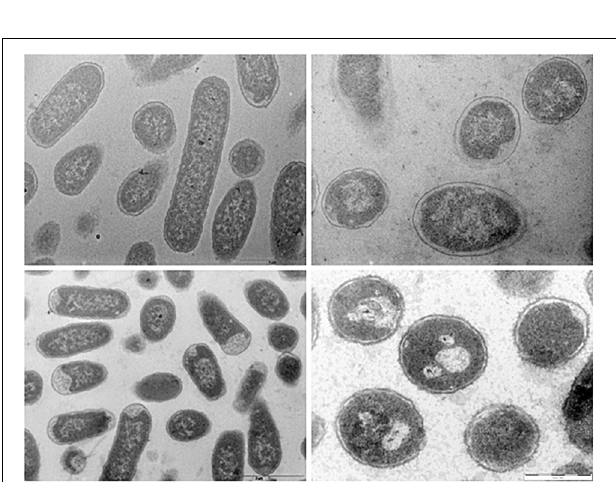
FIGURE 6 | Transmission electron micrographs. Control (above) and Fluopsin C-treated MRSA cells (below). TEM studies demonstrated that Fluopsin C induced internal cell